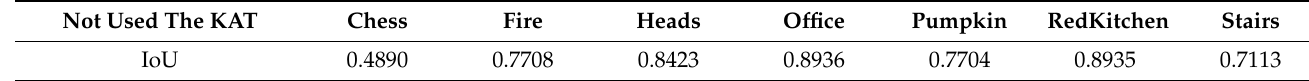
Table 4. IoU values without the keypoint attention mechanism.